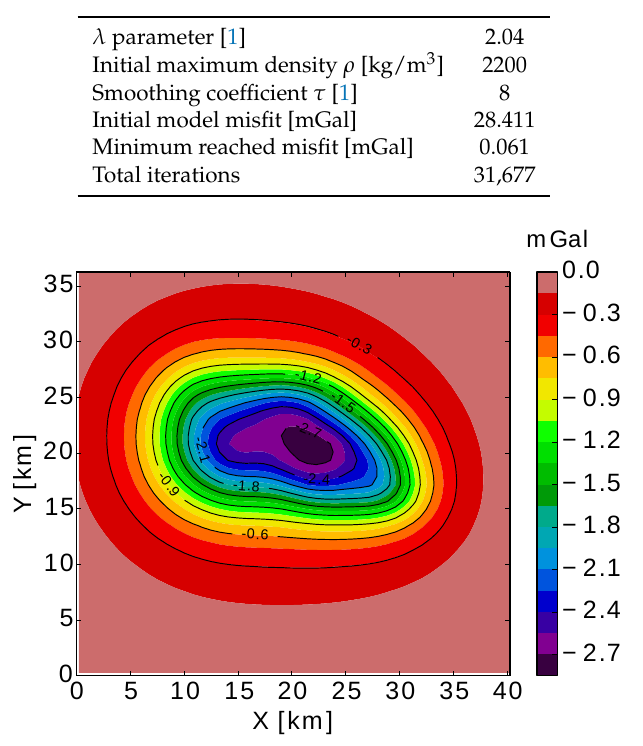
Figure 28. Initial (colour map) and inverted (contour lines) gravimetric ( G z ) response for the salt